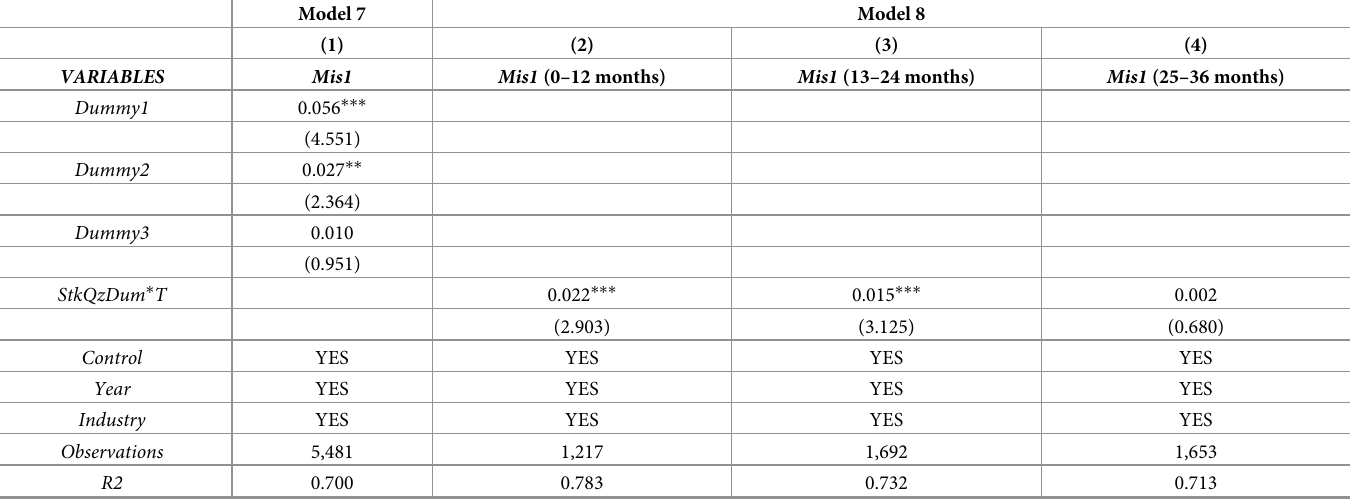
Table 5. VC Quan Zi’s exit time and asset